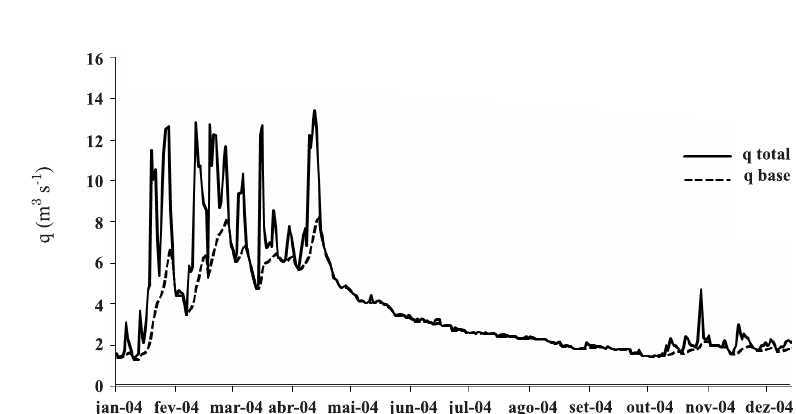
Figura 3. Decomposição do hidrograma em vazão total e escoamento de base para o ano de 2004, após a passagem do filtro digital.